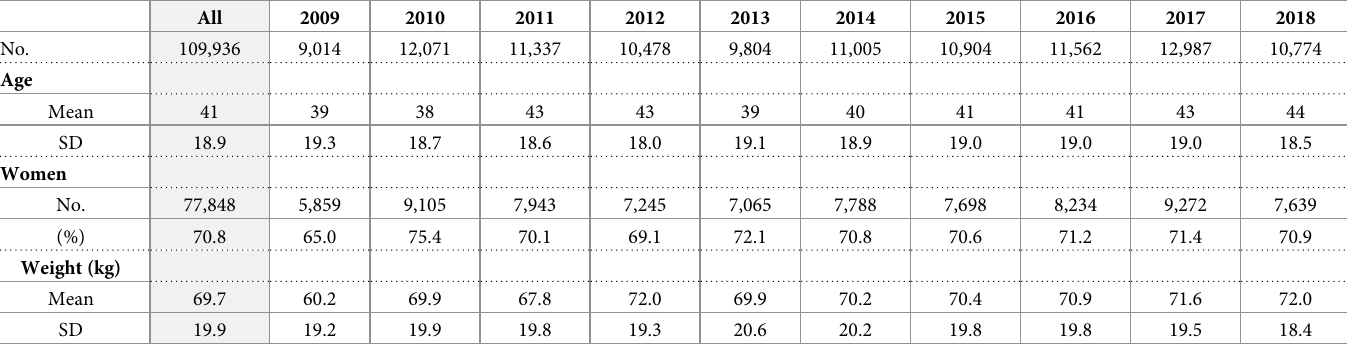
Table 1. Population, age, sex, and weight of the whole data set by